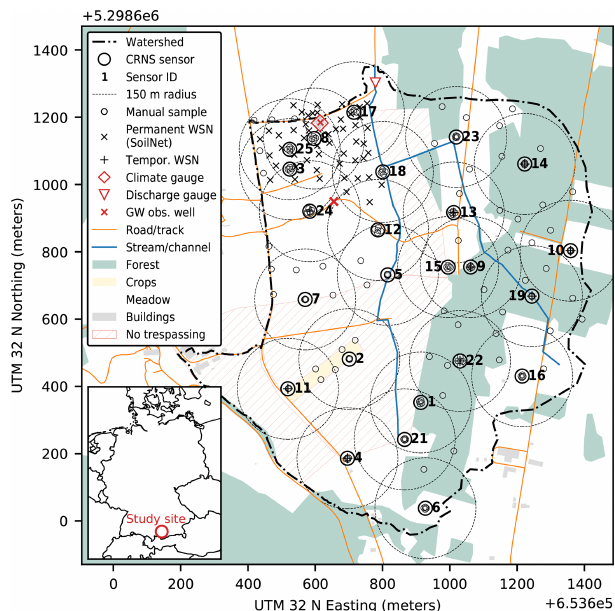
Figure 1. The Rott headwater catchment in Fendt near Peißenberg, Bavaria, Germany: the map shows the most important features of the study area and the JFC. In terms of land use, we only highlight the forested area and a patch of cropland – the remaining parts are mainly meadows or grassland, with some scattered settlements – as well as roads and streams. In terms of instrumentation, we fo- cus on showing the locations of the CRNS sensors with a 150m radius as a typical footprint size for a medium level of soil mois- ture (Schrön et al., 2017), the climate station, and soil moisture pro- files from SoilNet nodes and manual sampling on 25–26 June 2019. Basemap data are from OSM (OpenStreetMap contributors, 2020); see Sect.